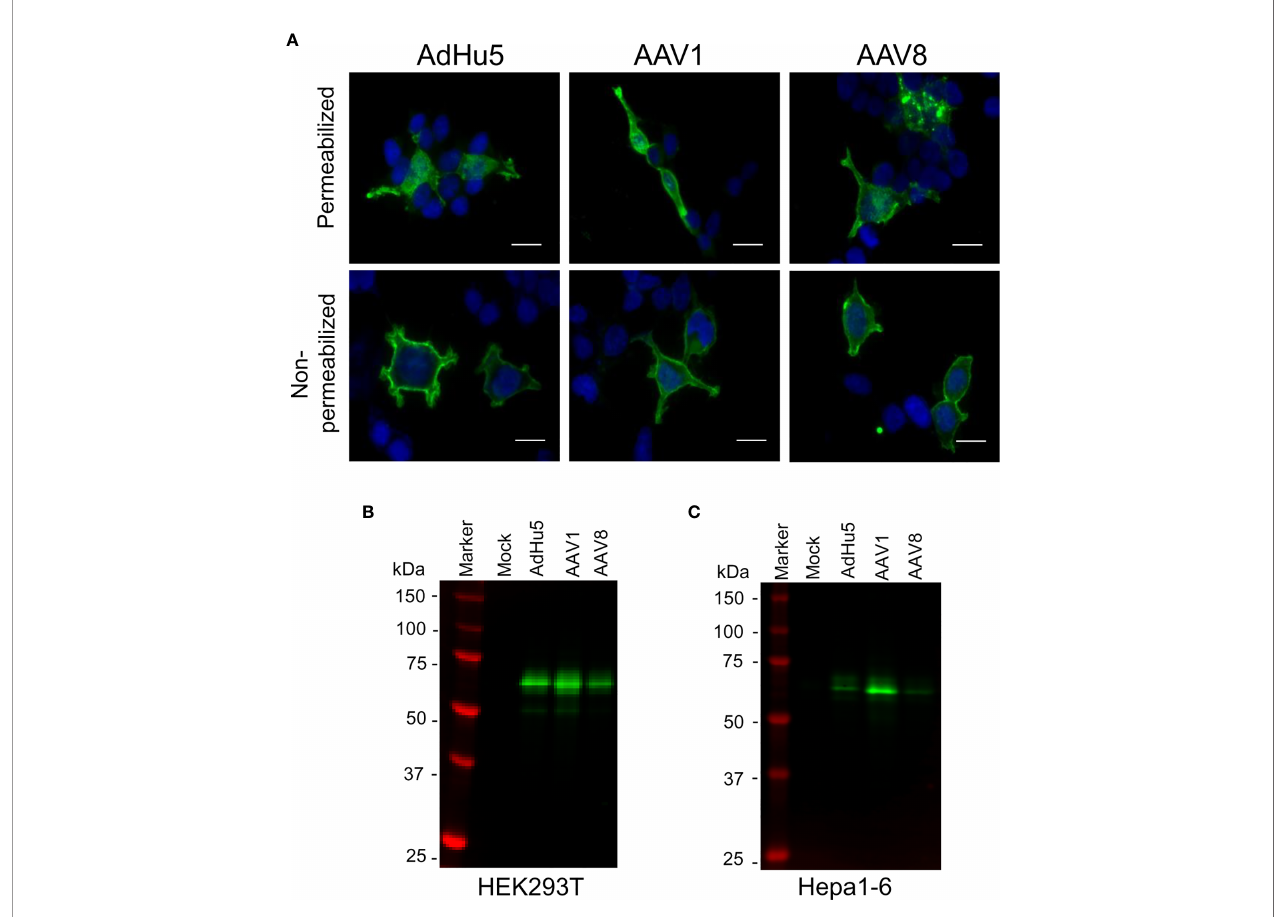
FIGURE 3 | PfCSP expression in cells transduced with AAV-PfCSP. (A) Cellular localization of PfCSP expression in transduced cells as assessed by an immuno fl uorescence assay. HEK293T cells were transduced with AdHu5-PfCSP (MOI = 3), AAV1-PfCSP (MOI = 10 5 ), or AAV8-PfCSP (MOI = 10 5 ). After 48 h, the cells were fi xed with methanol (permeabilized) or paraformaldehyde (non-permeabilized), and then treated with 2A10 mAb followed by FITC-conjugated anti-mouse secondary antibody and simultaneous staining with 4 ′ , 6-diamidino-2-phenylindole (DAPI; blue). Original magni fi cation, 1,000. Bars = 20 µm. (B, C) Detection of